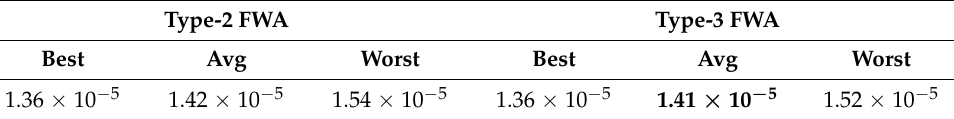
Table 7. First data period (testing prediction, China).